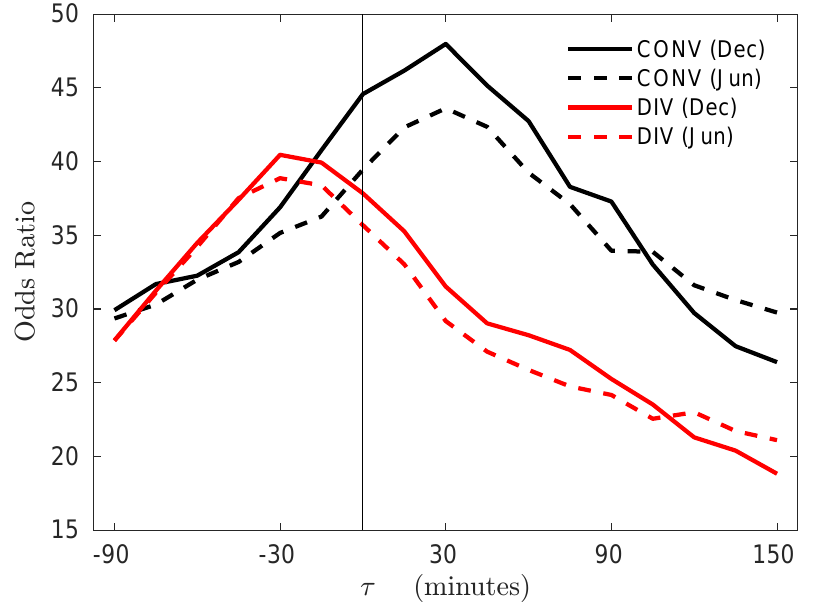
Figure 13. Odds ratios for convergence (black) and divergence (red) for a winter month and a summer month. Rain product lag is relative to SCAT-1 pass ( τ =